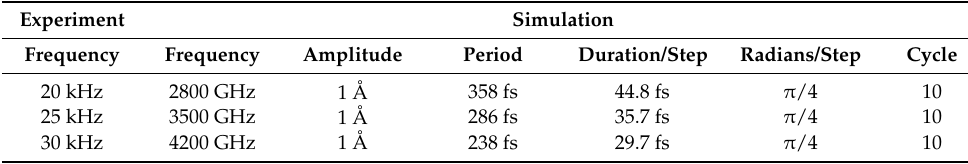
Table 4. Specifications of ultrasonic vibration simulation.